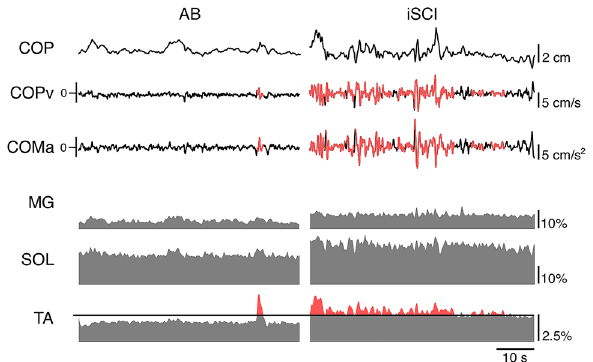
Figure 2. Representative traces of 60 s of the measured variables during quiet standing for both AB- and iSCI- groups. Specifically, the COP, COPv, and COMa are plotted for the AB-group, and iSCI-group in the first three rows. The last three rows are the EMG activity of the MG, SOL and TA. The horizontal black line across the TA row represents the activation threshold of 2.5%MVC. Periods where the TA EMG activity was greater than this threshold are shown in red, and the corresponding COPv and COMa periods are shown in red as